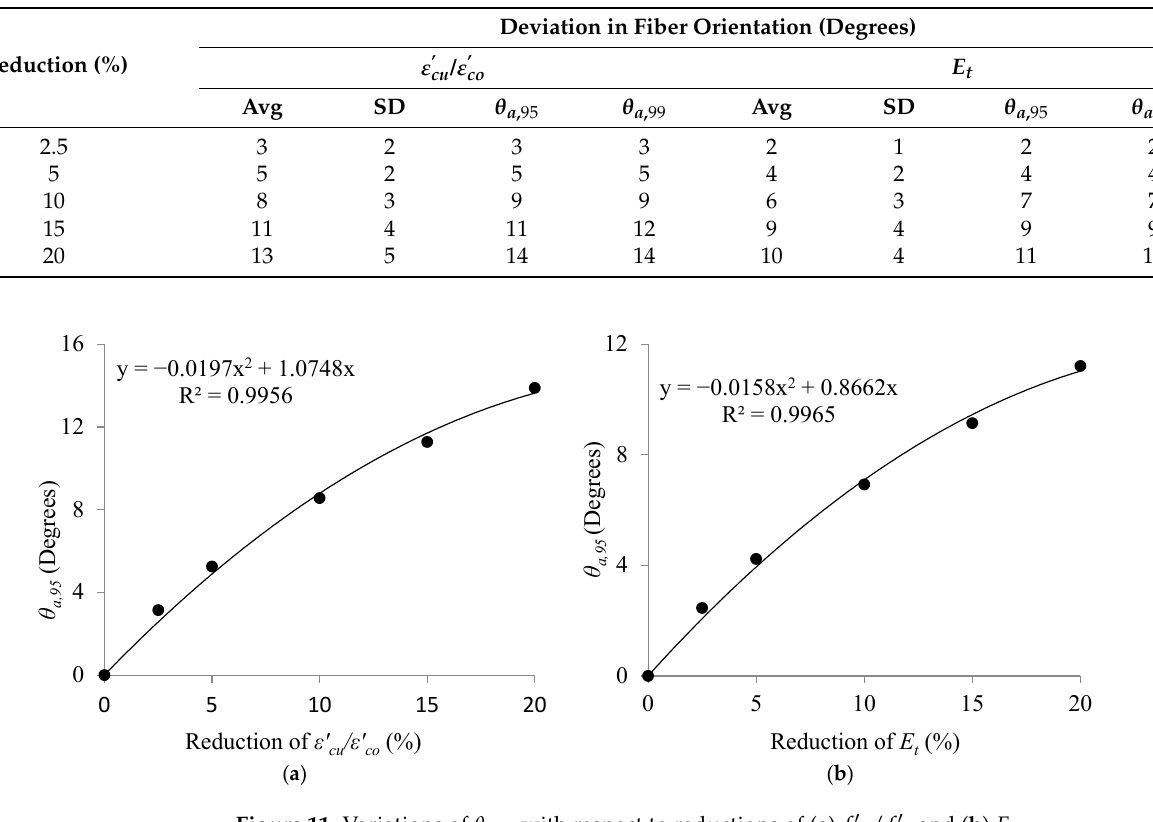
a ,95 with respect to reductions of ( a ) f